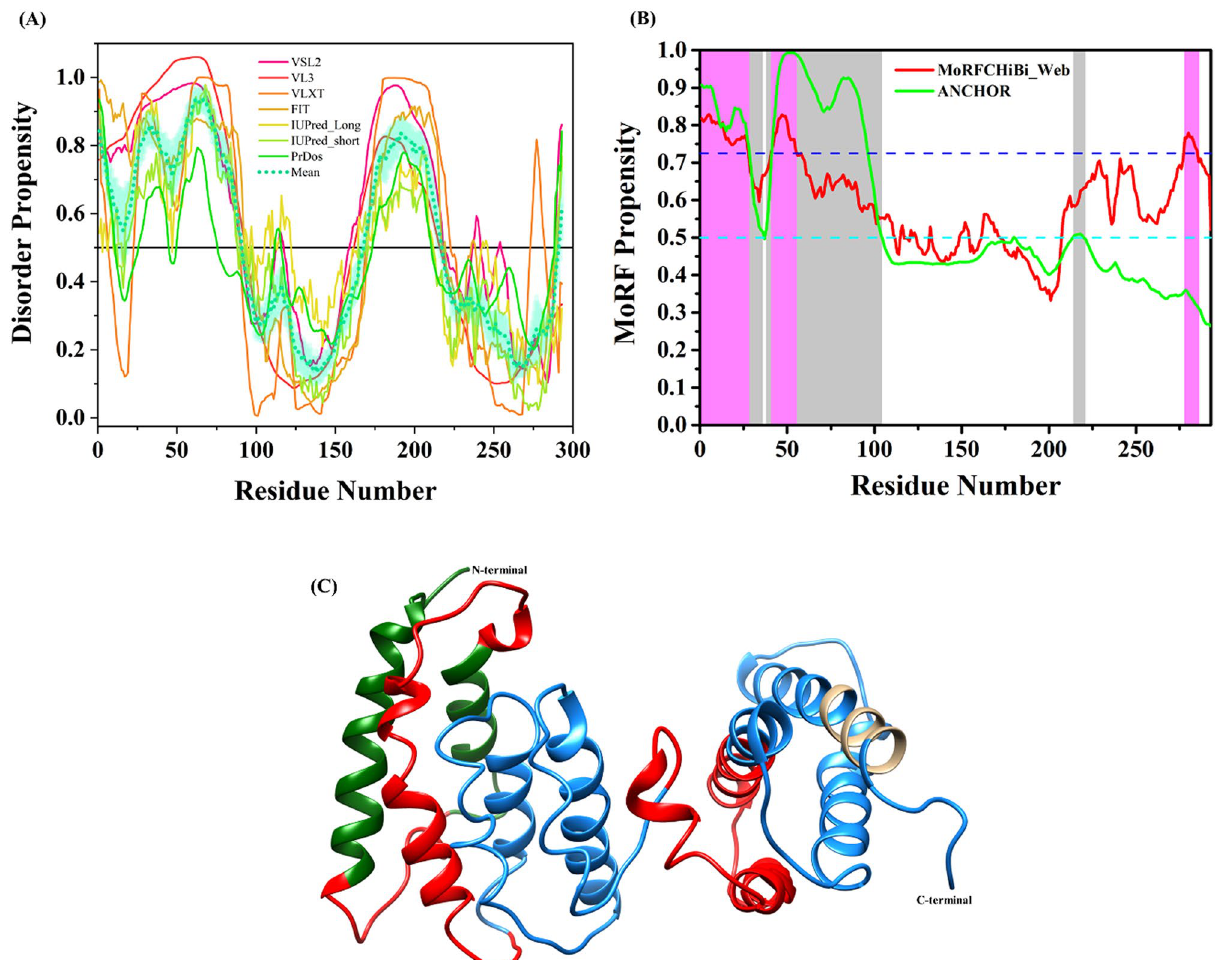
Figure 7. Intrinsic disorder predisposition of Phosphoprotein (P). ( A ) The intrinsic disorder profile generated for phosphoprotein by a set of disorder predictors; PONDR VSL2, PONDR VL3, PONDR VLXT, PONDR FIT, IUPred2_long, and IUPred2_short are represented by black, red, blue, magenta, dark yellow-, and navy-colored straight lines respectively. A mean disorder profile calculated by averaging the outputs of seven predictors is represented by the green-colored short-dash line. Light green region around mean curve represents the error distribution for the mean. ( B ) MoRFs prediction by MCW and ANCHOR server. The area with light magenta and light gray color signifies MoRFs region predicted by MCW and ANCHOR server, respectively. Dashed cyan line (0.5) represents cut-off for ANCHOR and dashed blue line (0.725) represents cut-off for MCW server. The area with light magenta color represents MoRF region predicted by MCW server. ( C ) Full-length modelled structure for P protein using I-TASSER web-server. The disordered (IDPRs), MoRFs residues and MoRFs in IDP predicted regions are shown in red, tan and green colors, respectively. The N- and C-terminals are shown with arrows in the